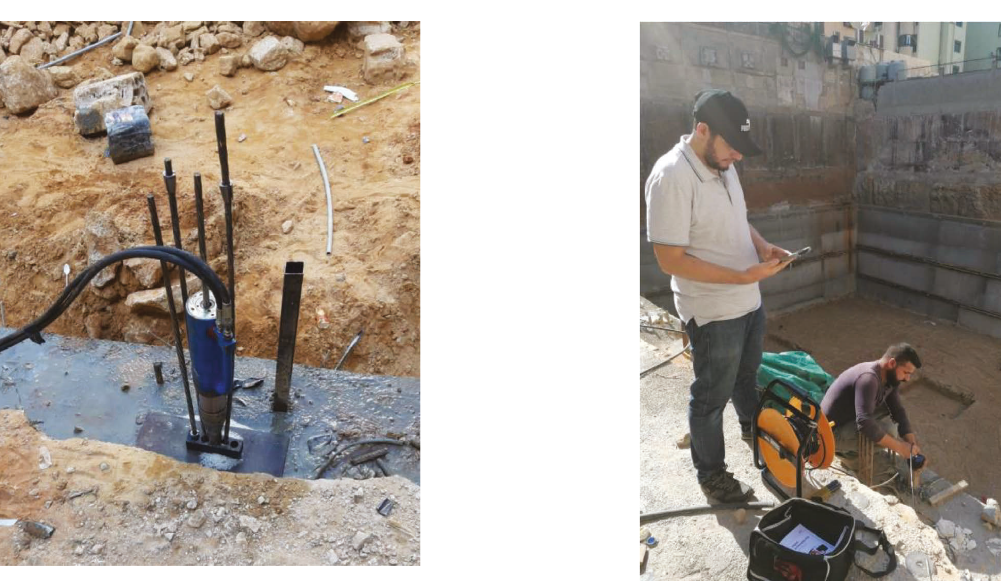
Figure 6: Strand